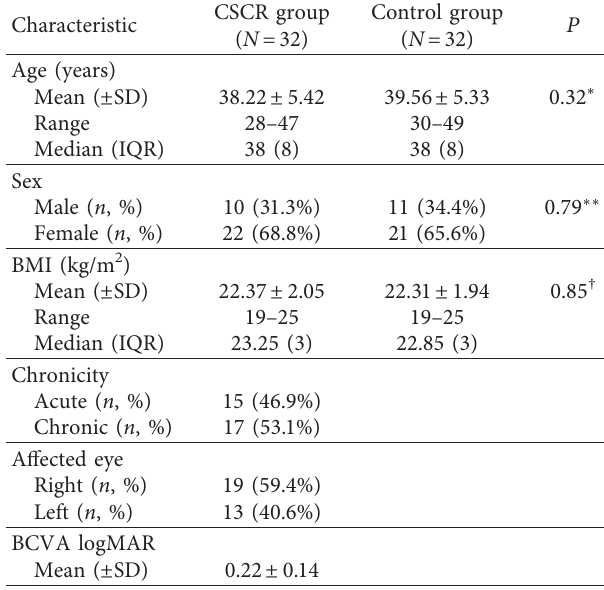
Table 1: Baseline demographics and characteristics of participants in each group.